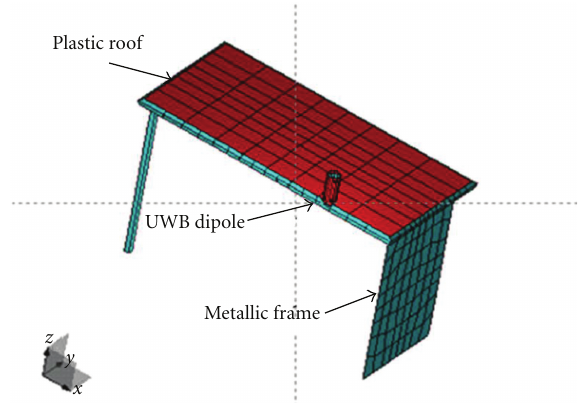
Figure 18: Antenna-urban equipment scenarios.